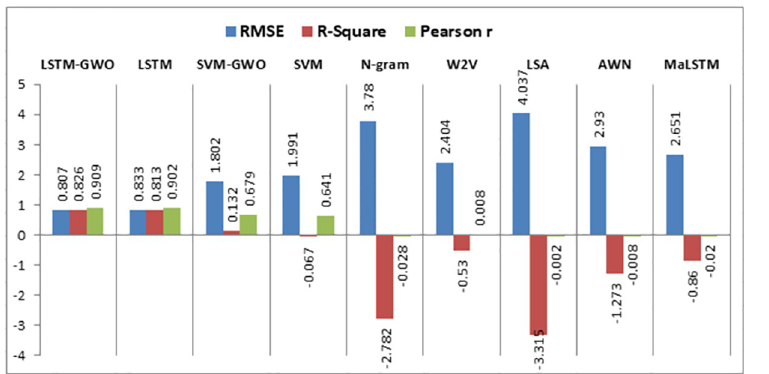
Fig 23. LSTM-GWO performance evaluation with experiment 1.